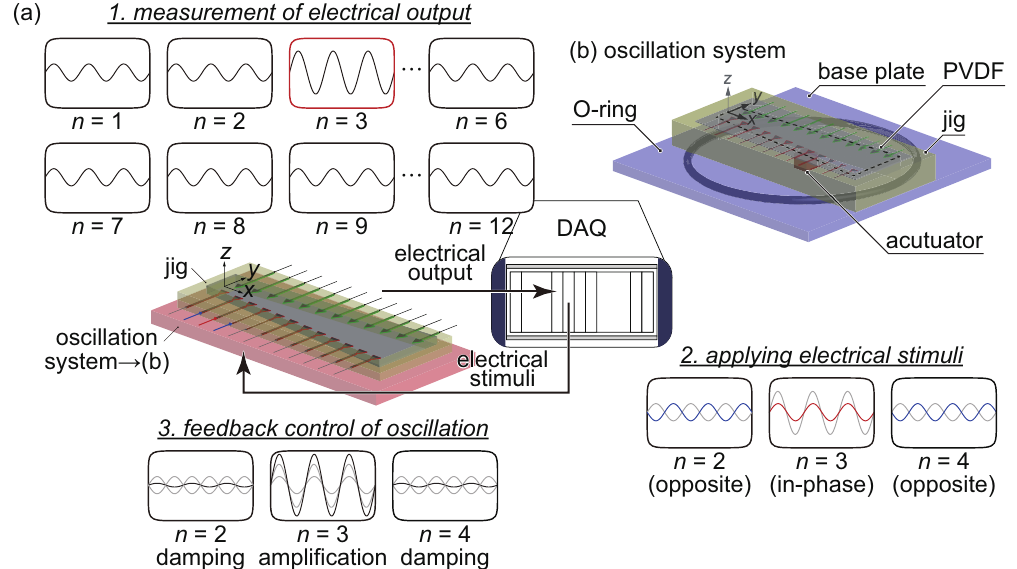
Figure 3. ( a ) Schematic of the feedback control system. A data acquisition (DAQ) system is used to measure the local electrical output produced by the oscillation of the device and to apply electrical stimuli. The device is actuated by the oscillation system shown in (b). ( b ) Schematic of the oscillation system. The oscillation system consists of a base plate, an O-ring, and an actuator. The PVDF membrane is fixed on a jig with a trapezoidal slit. The device is set on the base plate, which is oscillated by the actuator. The O-ring is used to uniformly oscillate the boundary of the device, and the amplitudes and phases of the boundary acceleration a B.C. ( t ) were made to be approximately constant at the multiple measurement points by optimizing the behavior of the actuator.